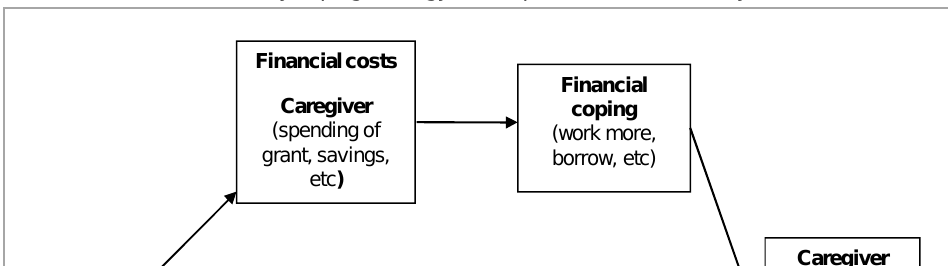
Elderly coping strategy model presented in this study Financialcosts Caregiver (spending of grant, savings, etc )